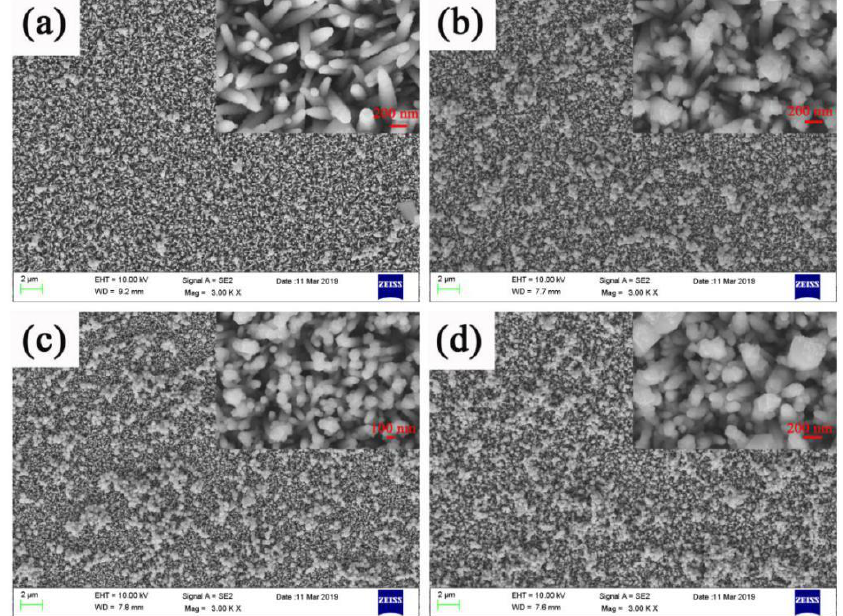
Figure 3. SEM images of ZnO nanorods + Ag + Ag 3 PO 4 : ( a ) Ag 3 PO 4 deposition once (6#), ( b ) Ag 3 PO 4 deposition three times (7#), ( c ) Ag 3 PO 4 deposition five times(8#), ( d ) Ag 3 PO 4 deposition seven times (9#).